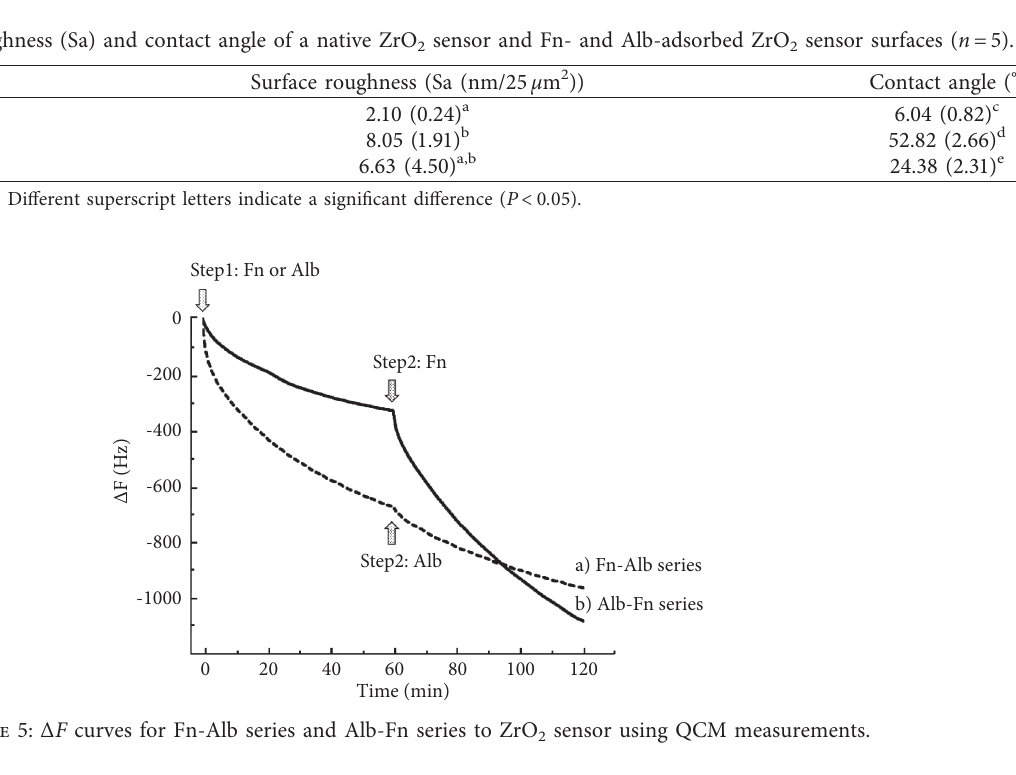
2 sensor using QCM